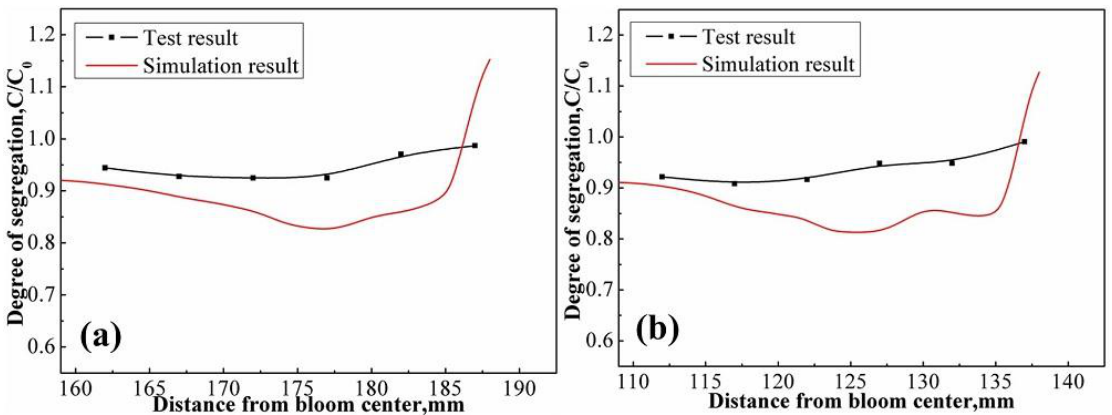
Figure 6. Comparison between measured and simulated segregation profiles of C in the region of initial solidification shell. ( a ) width direction; ( b ) thickness direction.